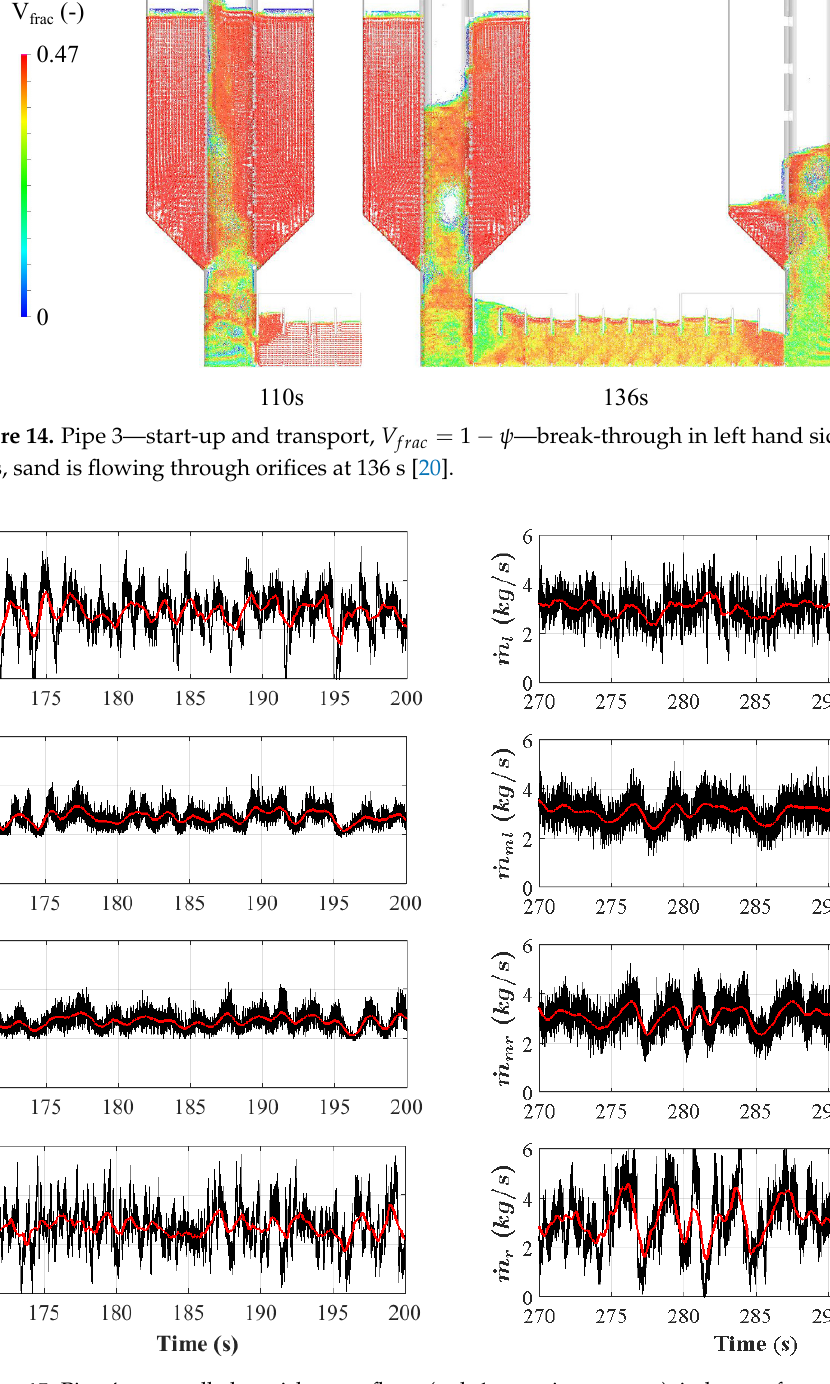
Figure 15. Pipe 4—controlled particle mass flows (red: 1 s moving average), indexes refer to Figure 4